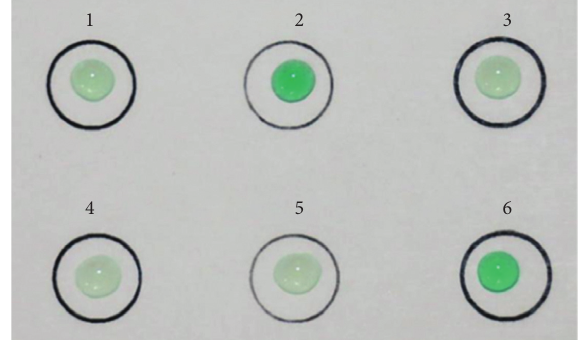
Figure 4: Visual-chip based detection of GmSg-1 . Each circle was coated with a mixture of HCR systems containing different hairpin probes and target genes with different sequences. Circles 1 and 4: the probes in the system were replaced with sterile ultrapure water as blank; target genes were GAa1/GAa2 and GAb1/GAb2, respectively. Circles 2 and 3: the probes in the system were all GAa1/GAa2; the target genes wereTAa and Tab,respectively. Circles 5 and 6: the probes in the system were all GAb1/GAb2; the target genes wereTAa and Tab,